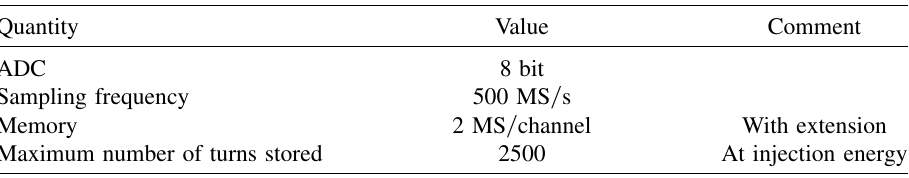
Key data of the